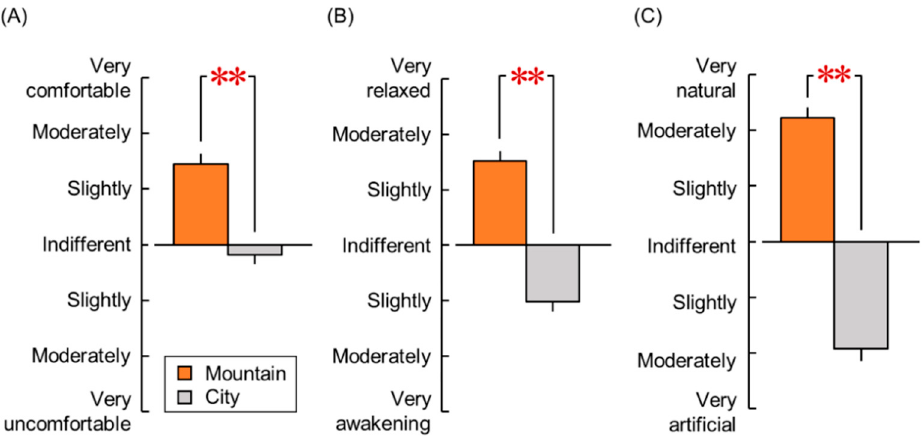
Figure 6. Psychological effects evaluated using the modified SD method based on three opposing adjective pairs after viewing the mountain and city images. ( A ) Comfortable versus uncomfortable. ( B ) Relaxed versus awakening. ( C ) Natural versus artificial ( n = 27, mean ± standard error). ** p < 0.01 (mountain vs. city). Wilcoxon signed-rank test.